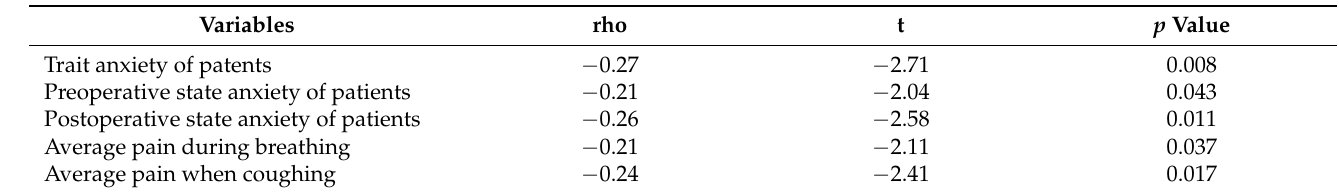
Table 7. Spearman’s rank correlations for analysis of the association between patient satisfaction from postoperative analgesia and anxiety and postoperative